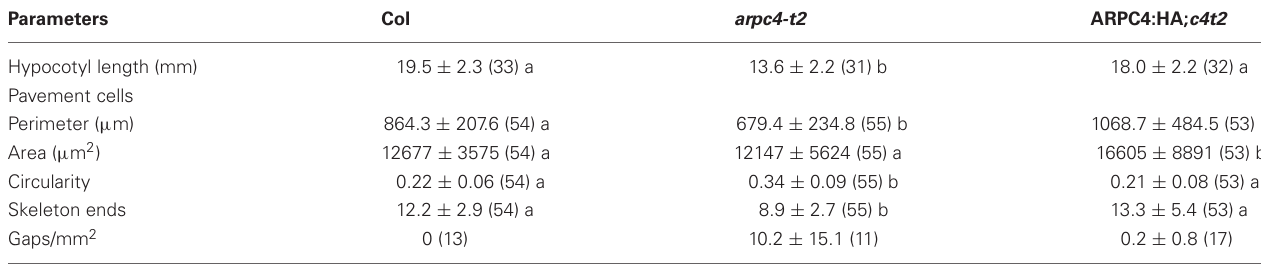
Table 1 | ARPC4:HA is functional in pavement cells and in dark grown hypocotyls. Parameters